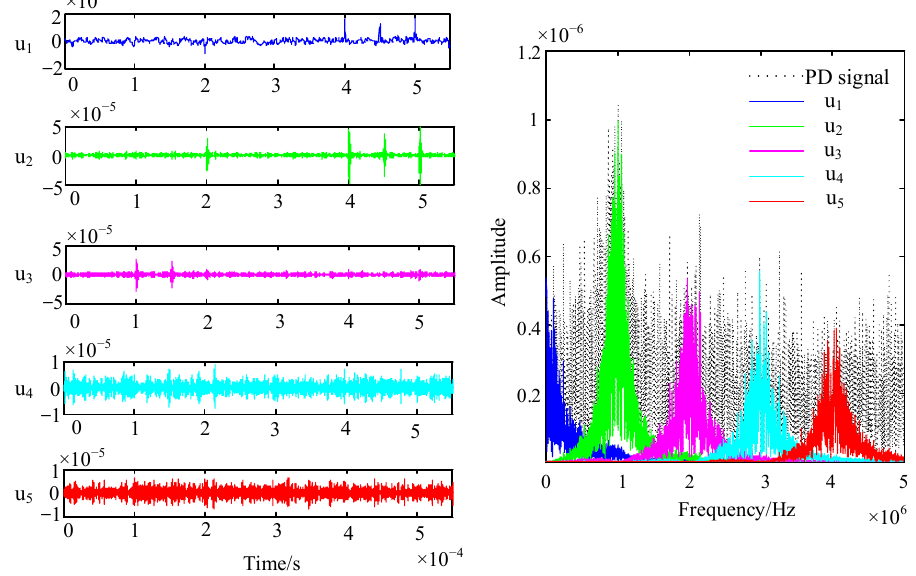
Figure 5. The decomposed eigenmodal components and their corresponding spectra, when K = 5.